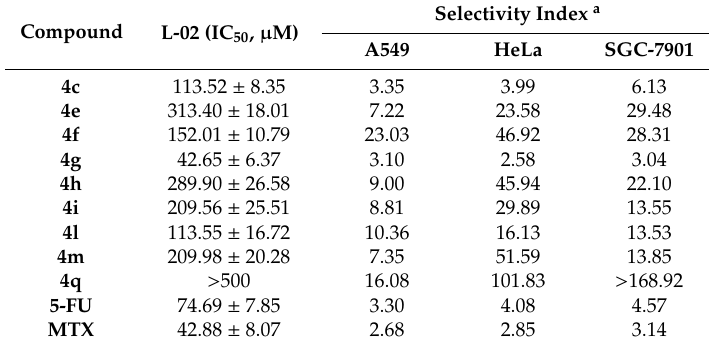
Table 2. In vitro cytotoxicity of nine compounds in the normal cell line L-02.